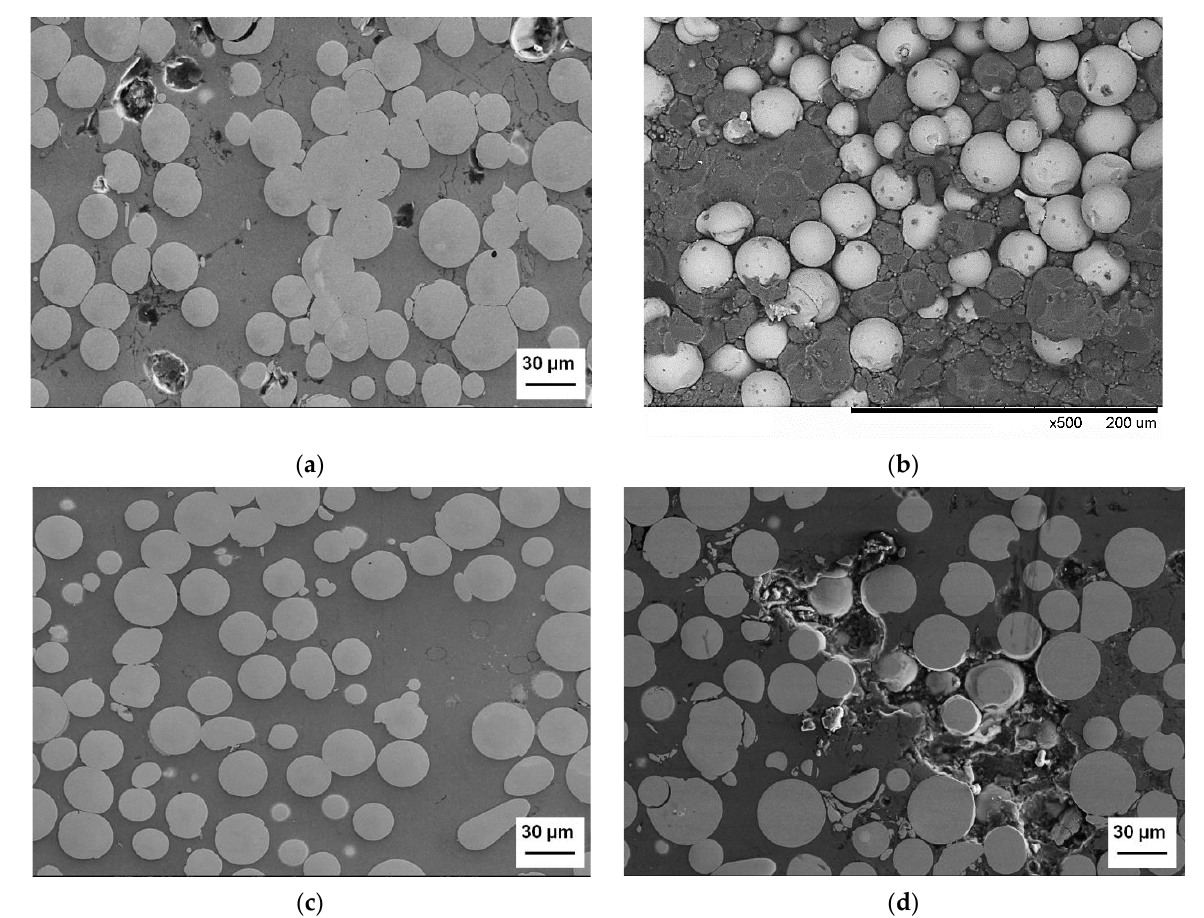
Figure 6. Microstructure of the spark plasma sintered composites obtained from ( a ) Al (coarse)–glassy Fe 66 Cr 10 Nb 5 B 19 , ( b ) Al (coarse)–crystalline Fe 62 Cr 10 Nb 12 B 16 mixtures, ( c ) Al (fine)–glassy Fe 66 Cr 10 Nb 5 B 19 , ( d ) Al (fine)–crystalline Fe 62 Cr 10 Nb 12 B 16 mixtures. ( a , c , d ) Micrographs of the polished cross-sections, SE images; ( b ) micrograph of the fracture surface, BSE image.